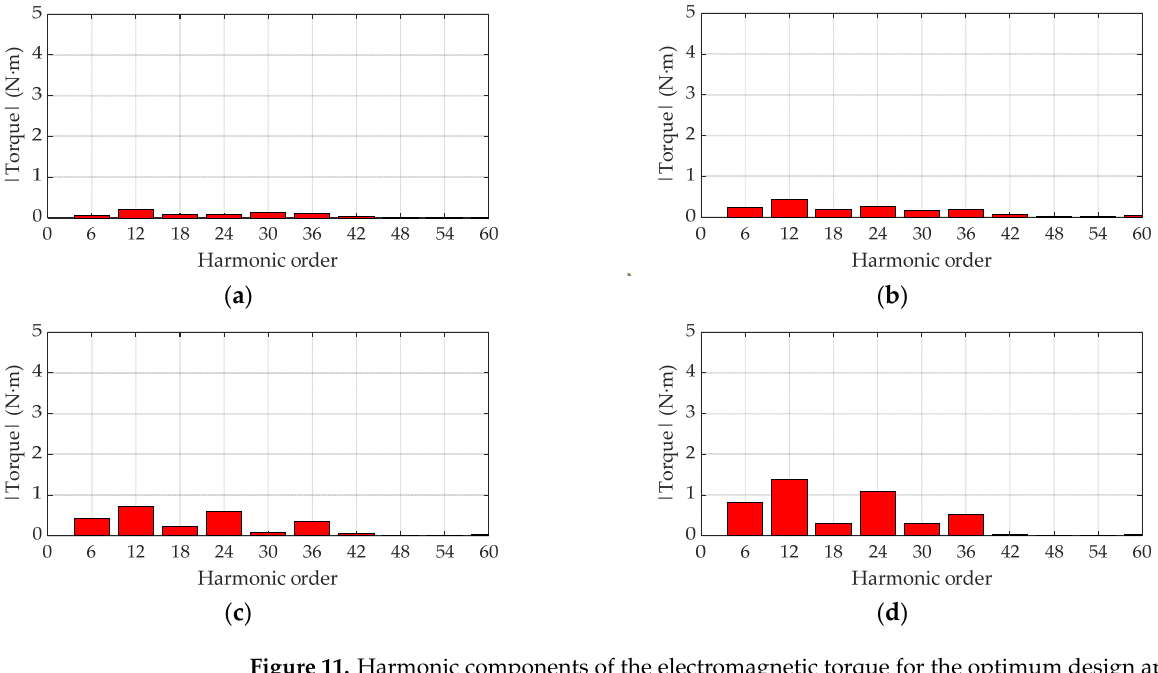
Figure 11. Harmonic components of the electromagnetic torque for the optimum design applying five-step skewing: ( a ) current density 5 A/mm 2 ; ( b ) current density 7.5 A/mm 2 ; ( c ) current density 10 A/mm 2 ; ( d ) current density 12.5 A/mm 2